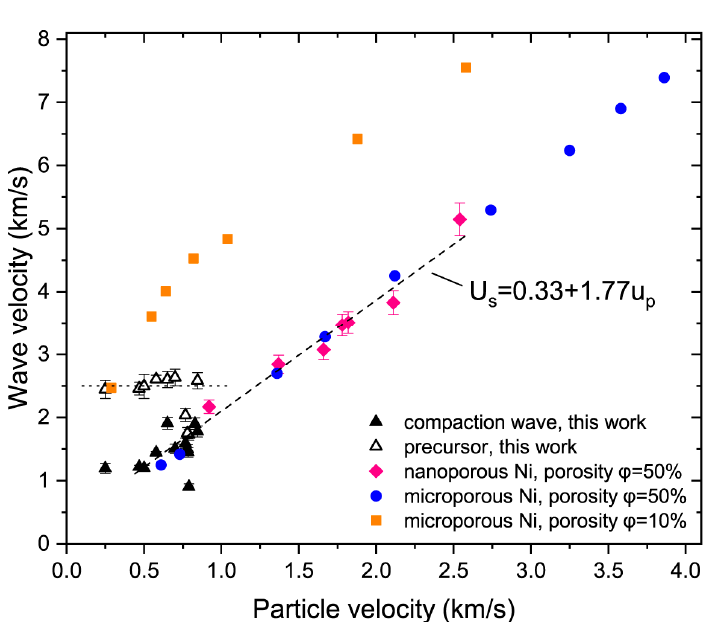
Figure 4. Hugoniot of nanoscale porous nickel on the shock wave velocity–particle velocity plane. Earlier points for nanoporous Ni [10] and microporous Ni [26] are also plotted.